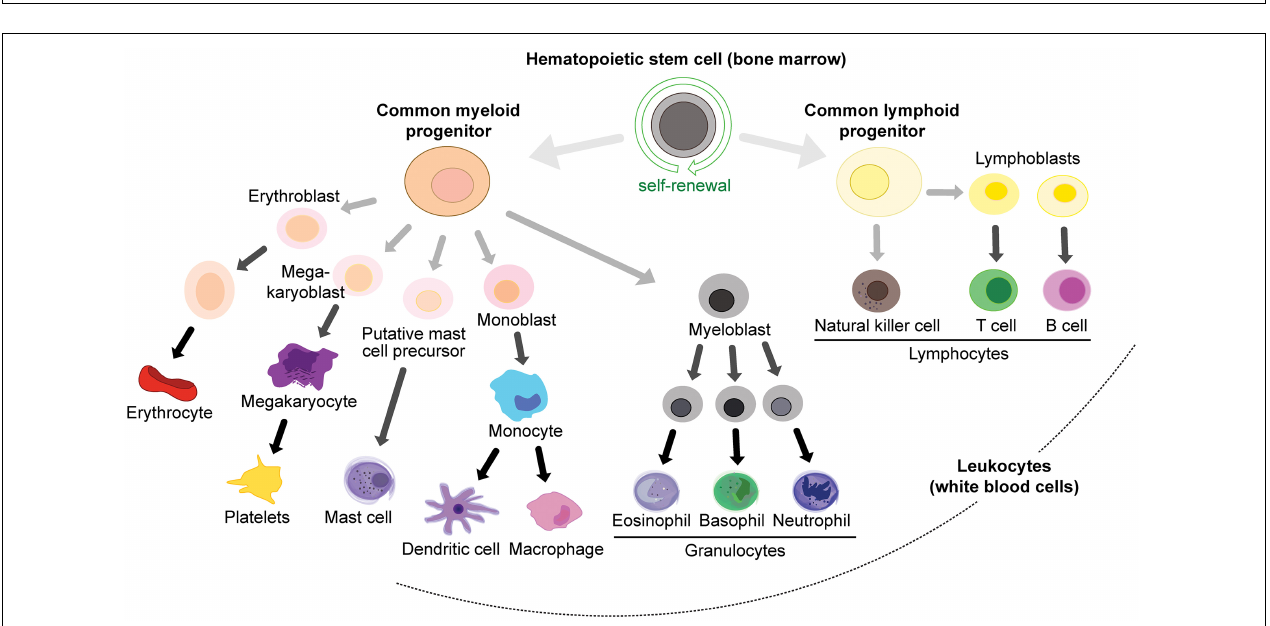
FIGURE 2 | Progression of secondary damage after physical damage is inflicted on the spinal cord. Blood flow is restricted as a result of damaged blood vessels, causing tissue acidification and subsequent activation of ASICs.